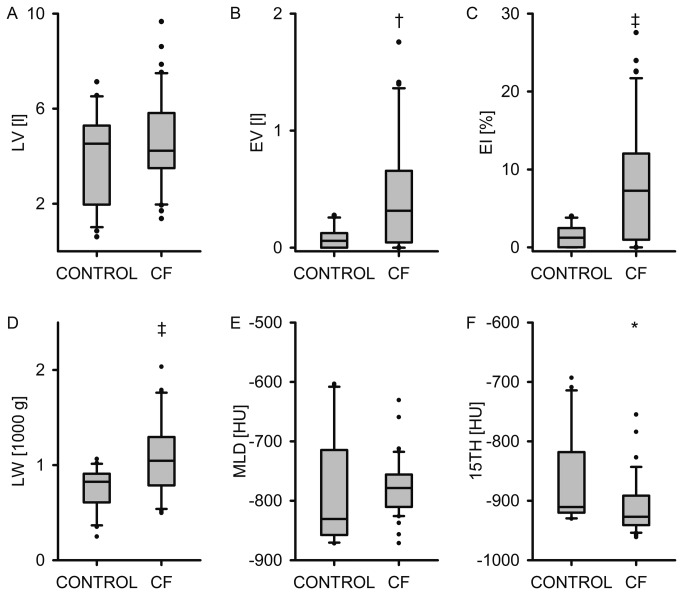
Quantification of emphysema in cystic fibrosis (CF) lung disease by densitometry.(A–F) Box-and-whisker plots for lung volume (LV) (A), emphysema volume (EV) (B) and emphysema index (EI) (C), lung weight (LW) (D), mean lung density (MLD) (E) and 15th percentile of the lung density histogram (15th) (F) in the non-CF control group (CONTROL) and patients with CF. The central line represents the median, the box encompasses the 25th-75th percentiles, whiskers show 10th and 90th percentiles, and closed circles (•) represent individual outliers. * P<0.05, † P<0.01 and ‡ P<0.001 compared to CONTROL.